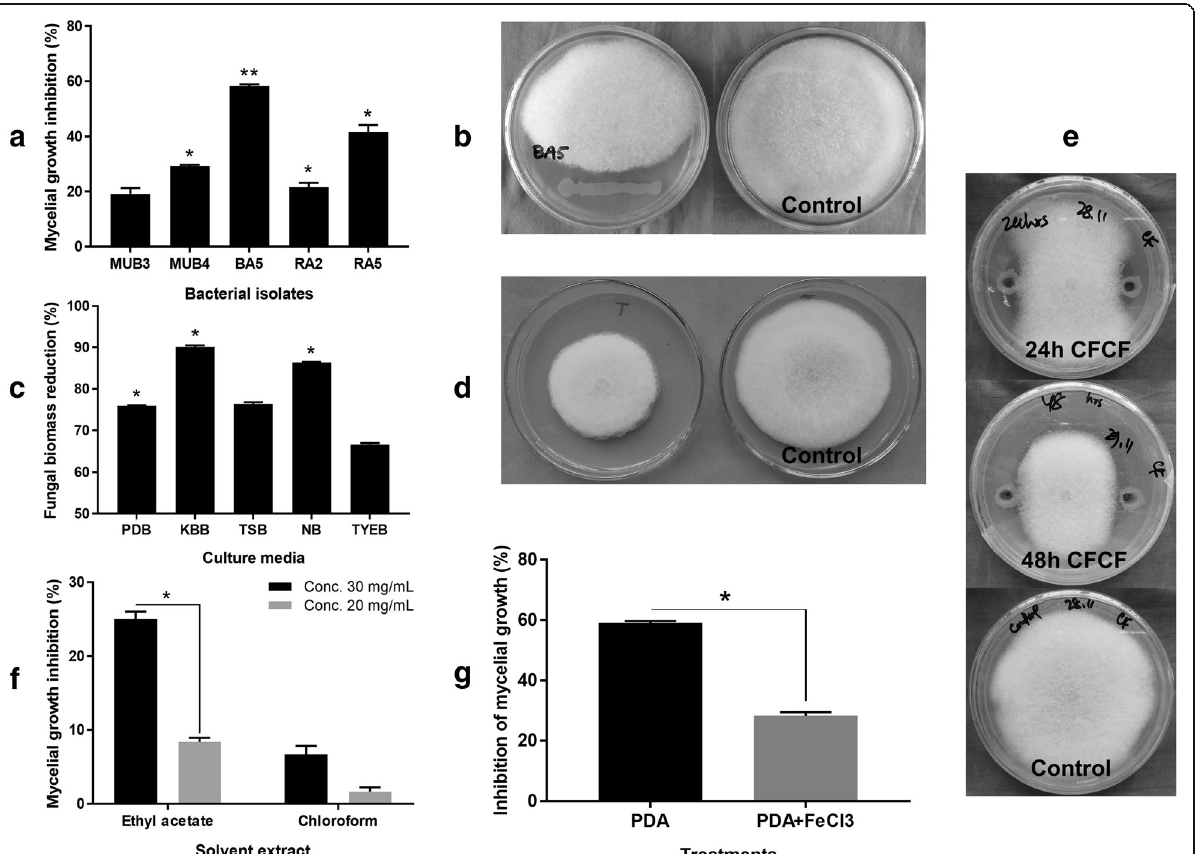
Fig. 1 Antagonism of isolate BA5 against Fusarium oxysporum f. sp. cucumerinum ( Foc ). a Antagonistic activity of soil bacterial isolates against Foc on potato dextrose agar (PDA), b antagonistic activity of isolate BA5 against Foc in dual culture on PDA after 5 days of culture at 27 ± 2 °C, c biomass reduction of Foc in broth-based dual culture with isolate BA5 in different media, d mycelial growth inhibition of Foc due to production of volatile compound(s), e Foc mycelial growth inhibition by cell-free culture filtrate from BA5 in dual culture on PDA, f antifungal activity of the solvent-aided crude substance of isolate BA5 against Foc , and g siderophore-mediated antagonism of isolate BA5 against Foc . Vertical bars represent standard deviations. The number of asterisks indicates the level of significance: a single asterisk (*) as significant ( P ≤ 0.05) and double asterisks (**) as highly significant ( P ≤